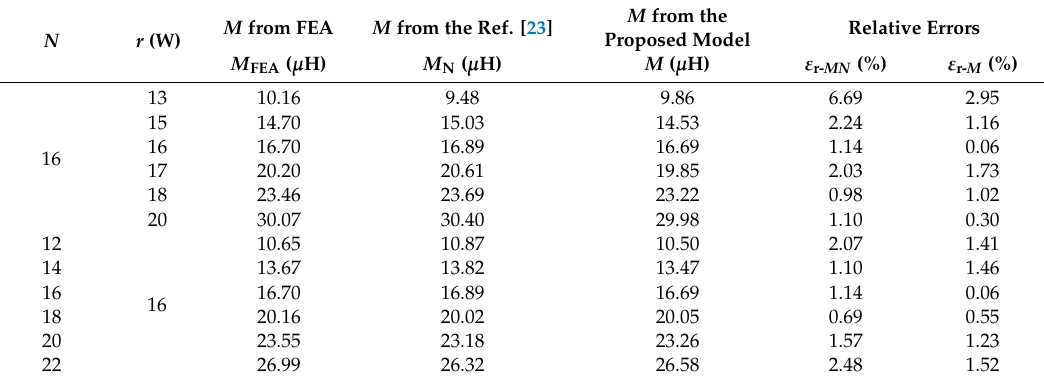
Figure 5. Comparison of results of the proposed model and FEA: ( a ) coil turns; ( b ) radius. In addition, the method relating to mutual inductance evaluation proposed in Ref. [23] was compared with the proposed method. The method in Ref. [23] is based on the numerical form of the Neumann formula. The calculated results of mutual inductance M through FEA, the method in Ref. [23], and the proposed method are shown in Table 3. The coils were divided into 400 segments in the method in Ref. [23] and the proposed method. The symbol M N is the calculated results of M using the method in Ref. [23]. The symbol ε r ‐ MN is the relative error between M N and M FEA . It can be seen from the relative error that the proposed method is more accurate for most coil models. Table 3. Comparison of the calculated value of mutual